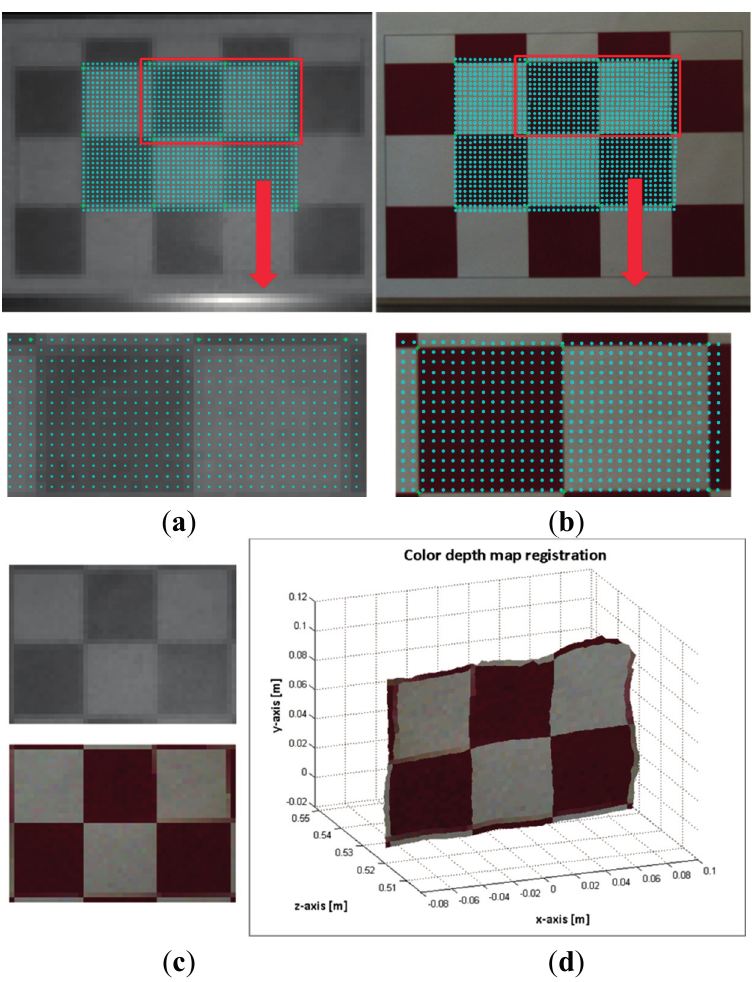
Figure 8. Image sample 49-pattern board positioned at 527 mm. ( a ) Top: selected ROI on the ToF image. Bottom: zoom of the selected points on the ToF image; ( b ) Top: mapped points on the RGB image. Bottom: zoom of the estimated points on the RGB image; ( c ) Top: ROI of the ToF image. Bottom: Composition ROI from the mapped points on the RGB image; ( d ) colour depth